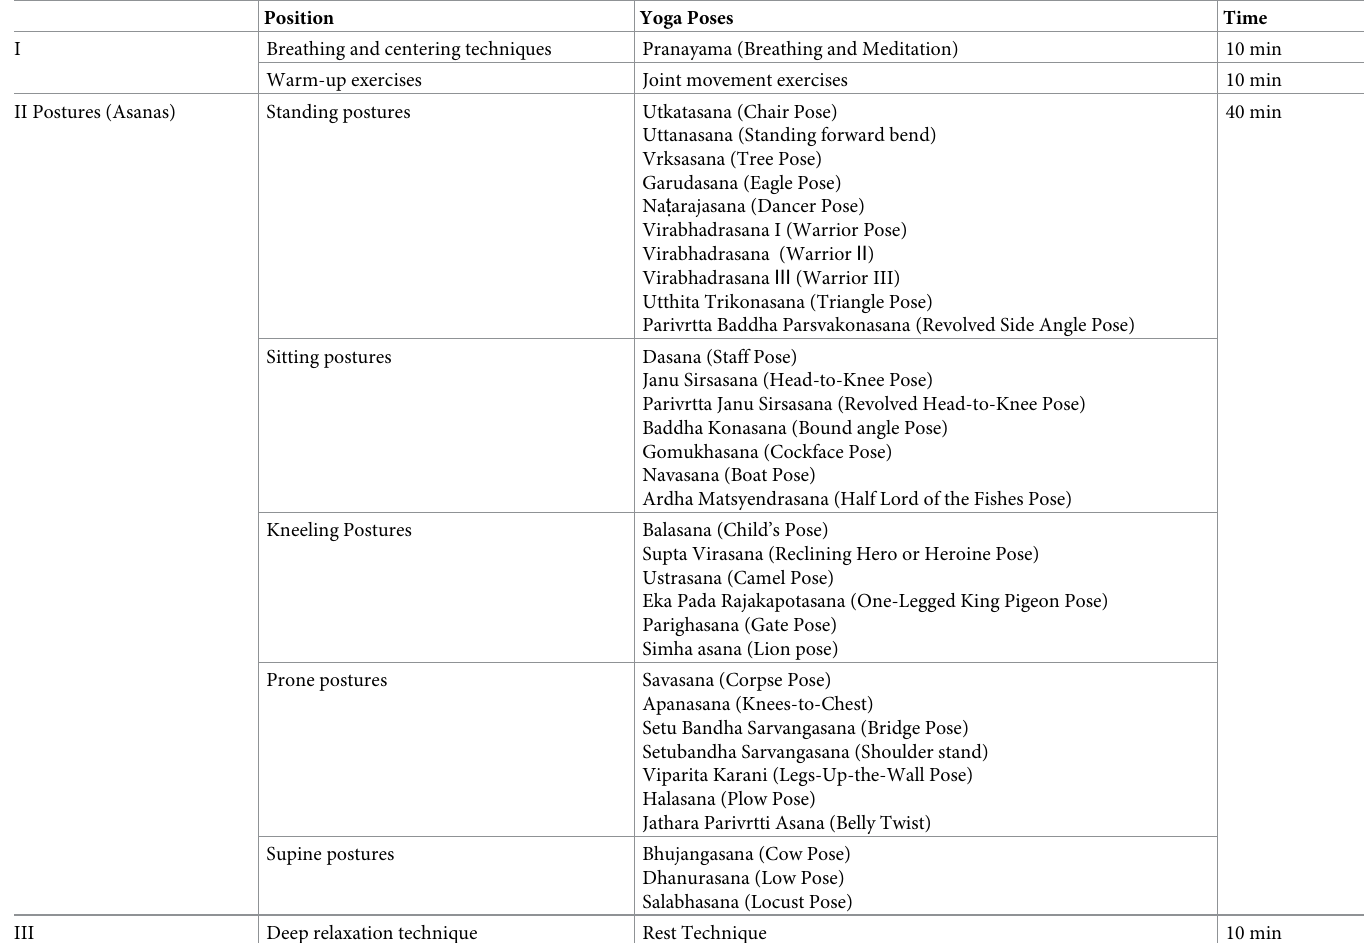
Table 1. Contents of yoga practice for the 16-week training program.